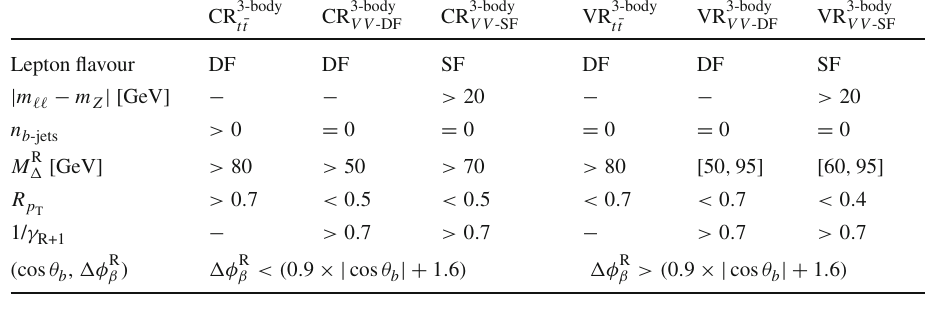
background fit results for the CRs of the SR 3-body and W SR 3-body t background fit. The nominal predictions from MC simulation, are given for comparison for those backgrounds ( t ¯ t , V V -DF and V V -SF) that are normalised to data in dedicated CRs. Combined statistical and systematic uncertainties are given. Entries marked “–” indicate a negligible background